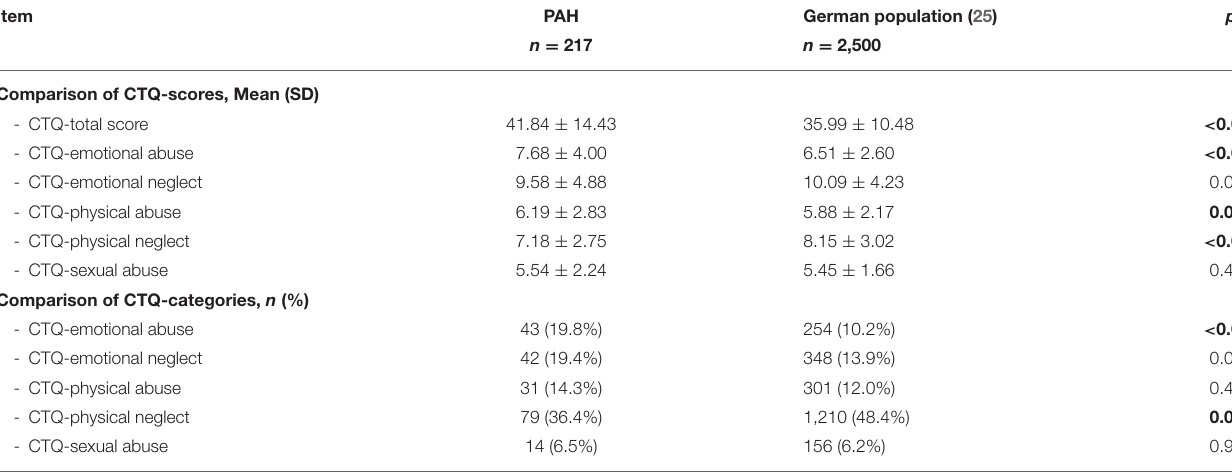
TABLE 2 | Scores and prevalence of child maltreatment in patients with PAH compared to German